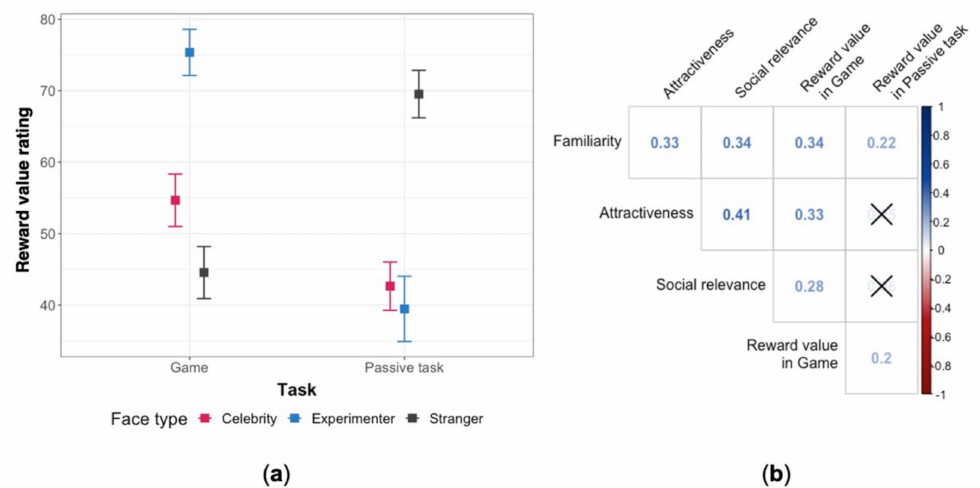
Figure 2. ( a ) Mean subjective ratings of the reward value of each type of face in the repeat-a-pattern game and the passive task. The error bars represent standard errors. ( b ) Correlogram (Pearson) of the ratings: social relevance, familiarity, reward value, and attractiveness. For clarity, the crosses mark statistically insignificant correlations ( p -values were adjusted with Holm correction), however, this is an exploratory analysis and p -values should not be considered